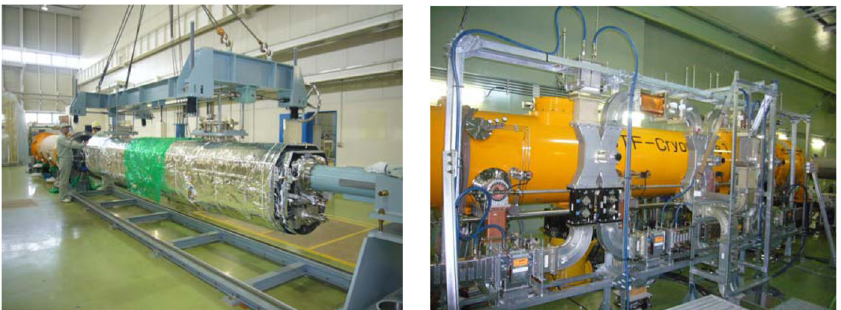
FIG. 9. (Color) Insertion of assembled cold mass into vacuum vessel (left) and installation of cryomodule in STF tunnel (right).